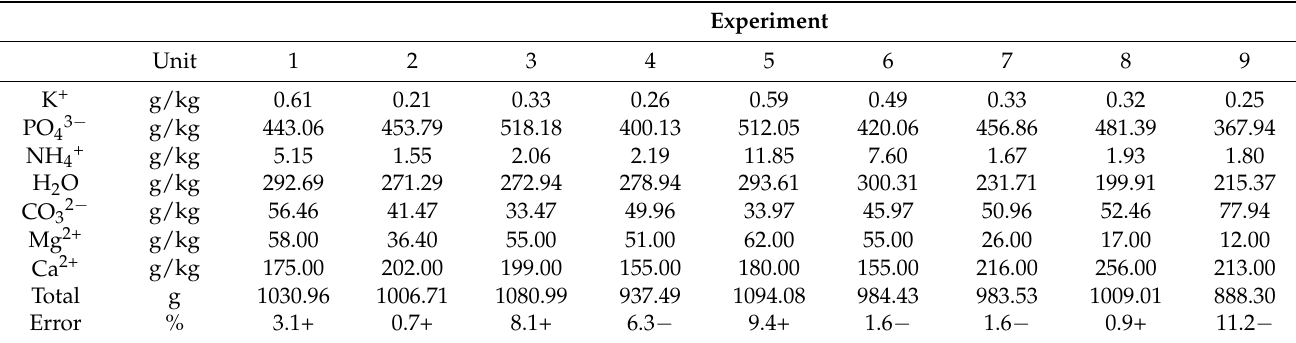
Table 5. Composition of final precipitates in terms of ionic groups.